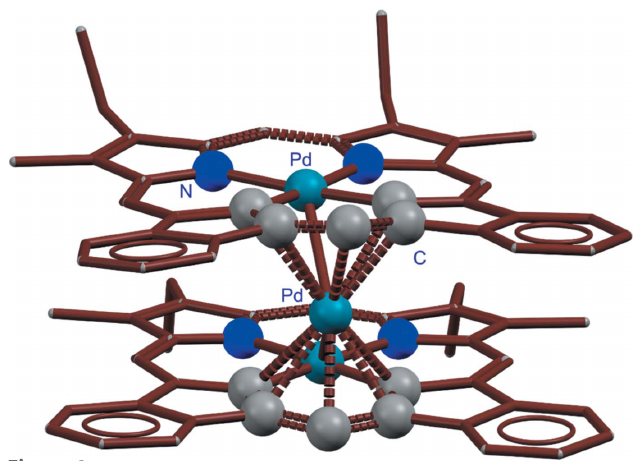
Figure 8 Mercury rendering highlighting the metal coordination environment of CSD-RIYGUD.